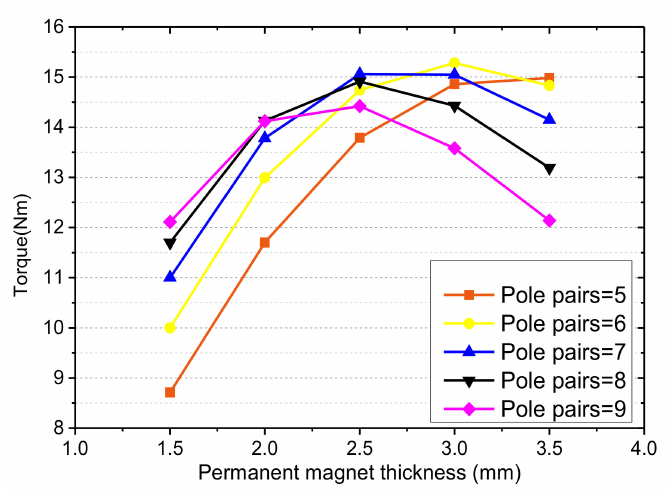
Figure 16. S T versus pole arc coe ffi cient for several pole pairs.